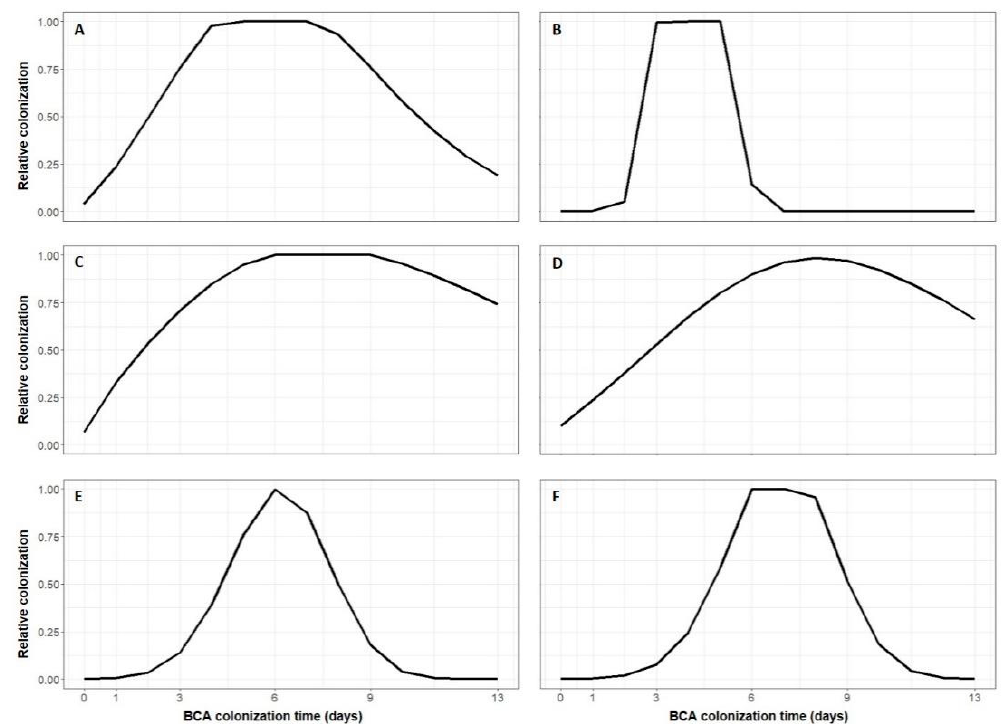
Figure 6. Progress of the relative colonization of bunch trash that was treated with one of six BCAs ( A : AMY; B : BOT; C : NOL; D : SER; E : TAE; F : VIN, see Table 1) and then incubated at the optimal temperature (AMY: 30 ◦ C, BOT: 25 ◦ C, NOL: 15 ◦ C, SER: 25 ◦ C, TAE: 25 ◦ C, and VIN: 30 ◦ C) and 100% RH; after 1, 3, 6, 9, and 13 days, the number of CFUs was assessed. Lines were drawn using Equation (6) and the parameters listed in Table 4.